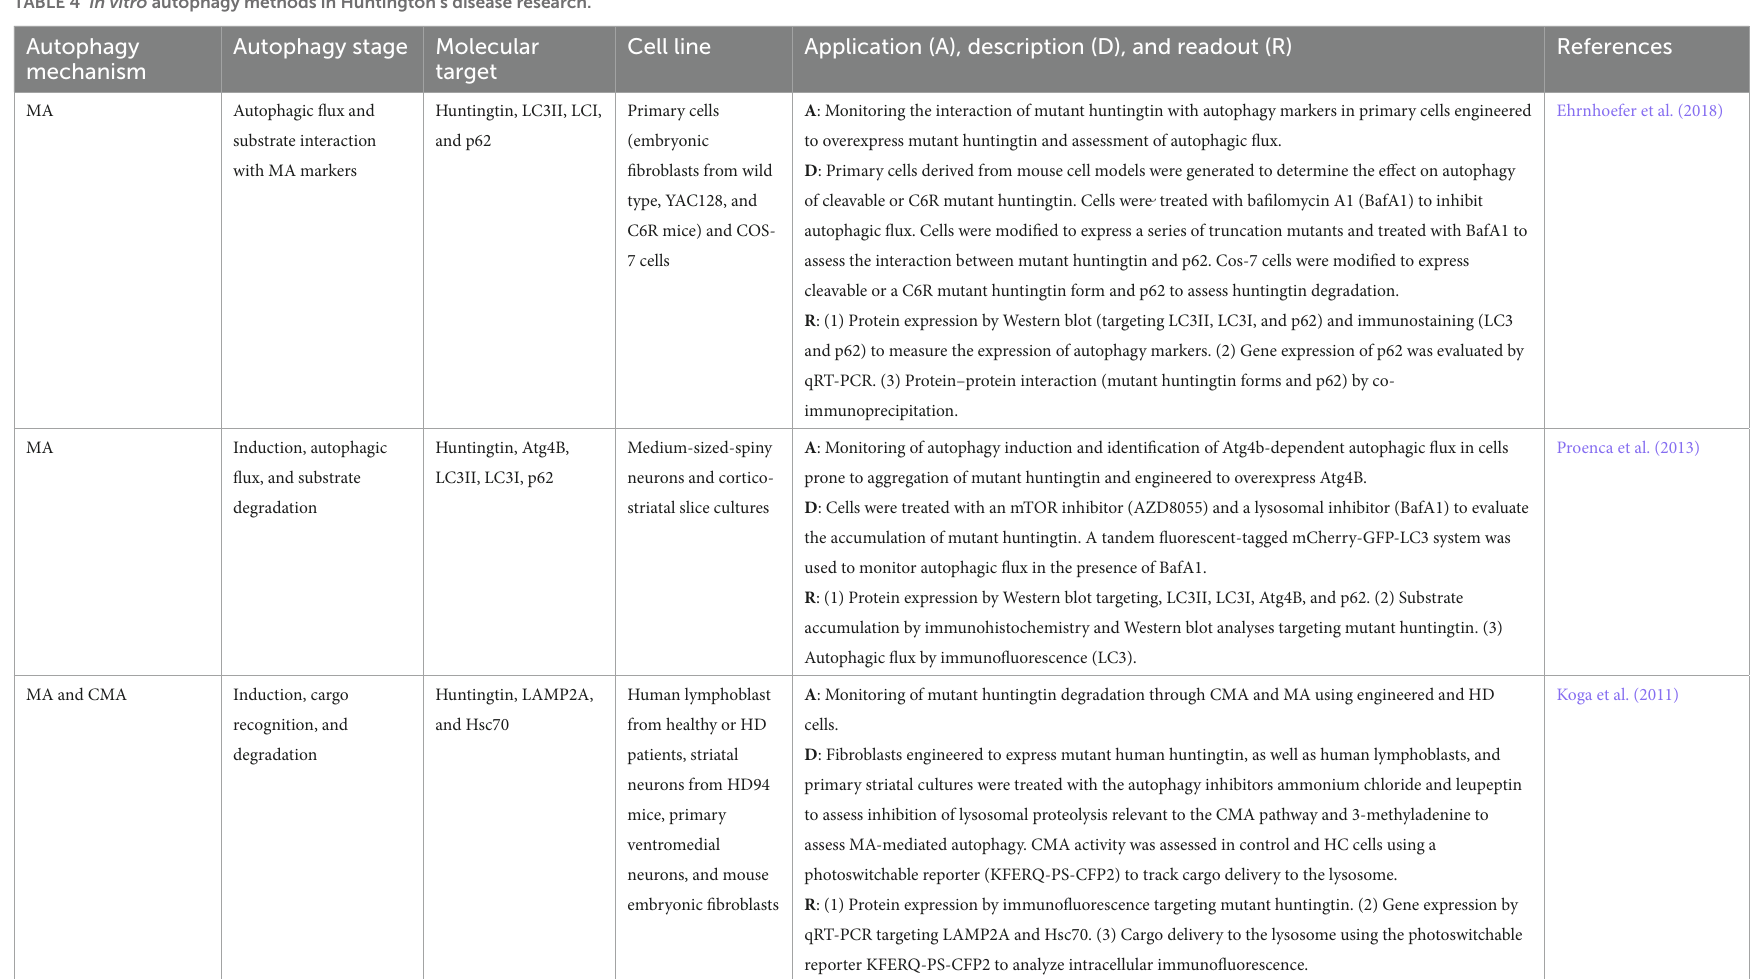
TABLE 4 In vitro autophagy methods in Huntington’s disease